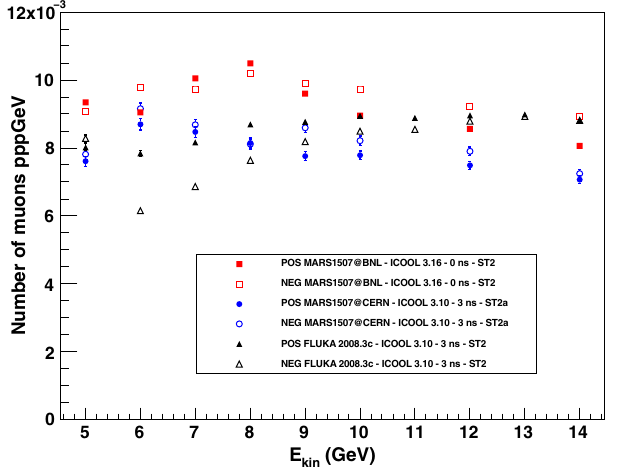
FIG. 2. The accepted muon yield per proton per GeV as a function of proton beam kinetic energy. The different points show what effect different simulation code versions have on the yield calculation results. ST2a and ST2 denote different B field tapering parameters. For ST2a (ST2), j B j adiabatically decreases from 20 to 1.75 T (1.25 T) over a length of 12 m (18 m).